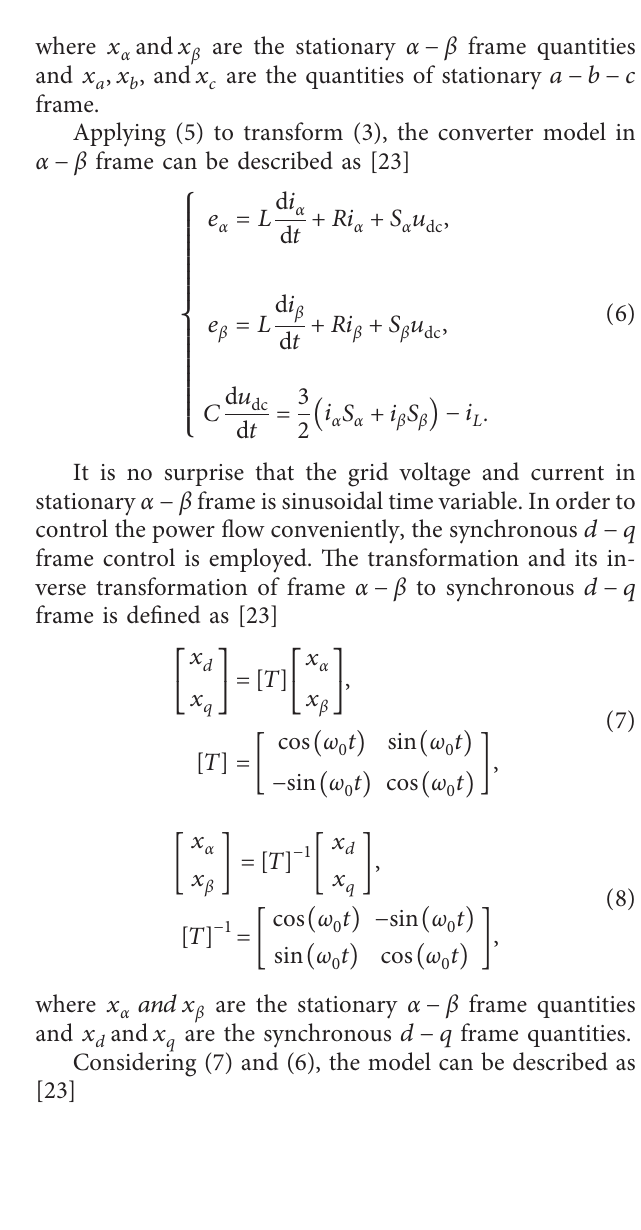
Figure 1: System configuration.